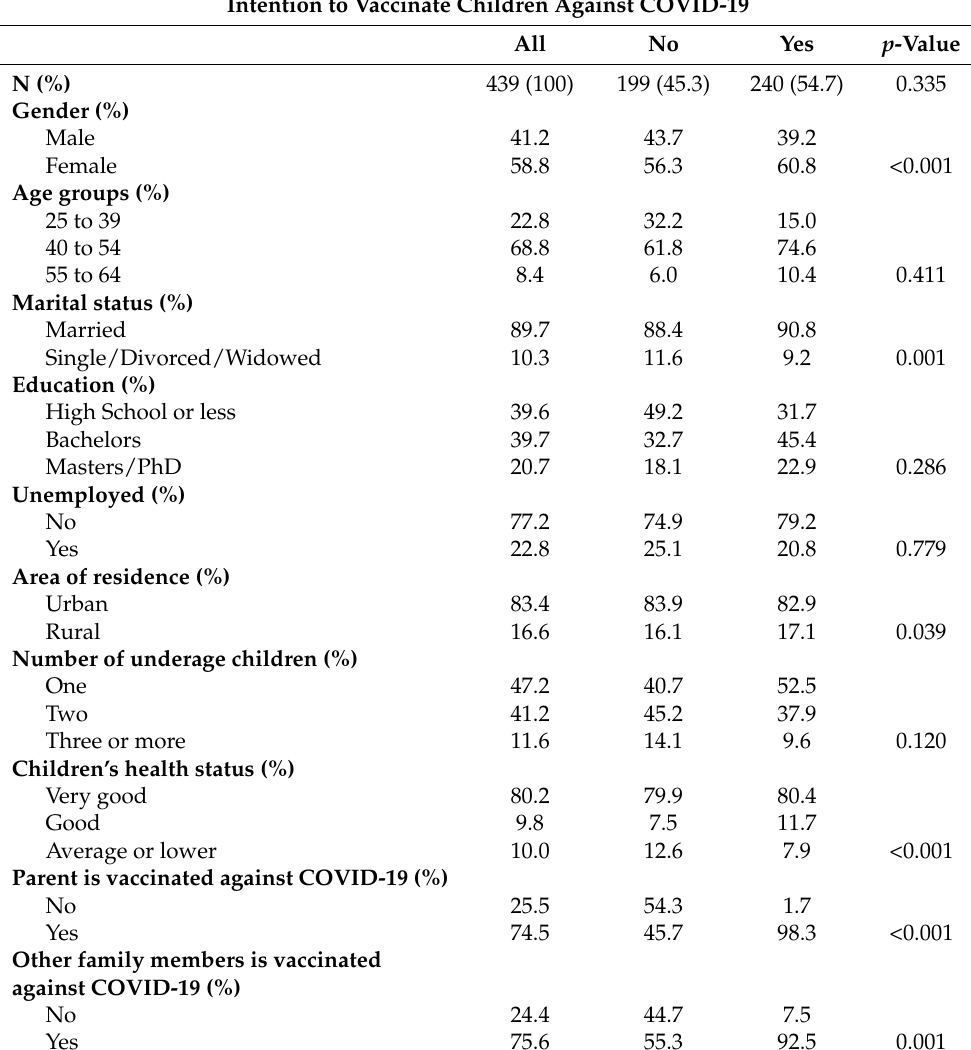
Table 1. Descriptive characteristics overall and stratified by parental intention to vaccinate their children. Intention to Vaccinate Children Against